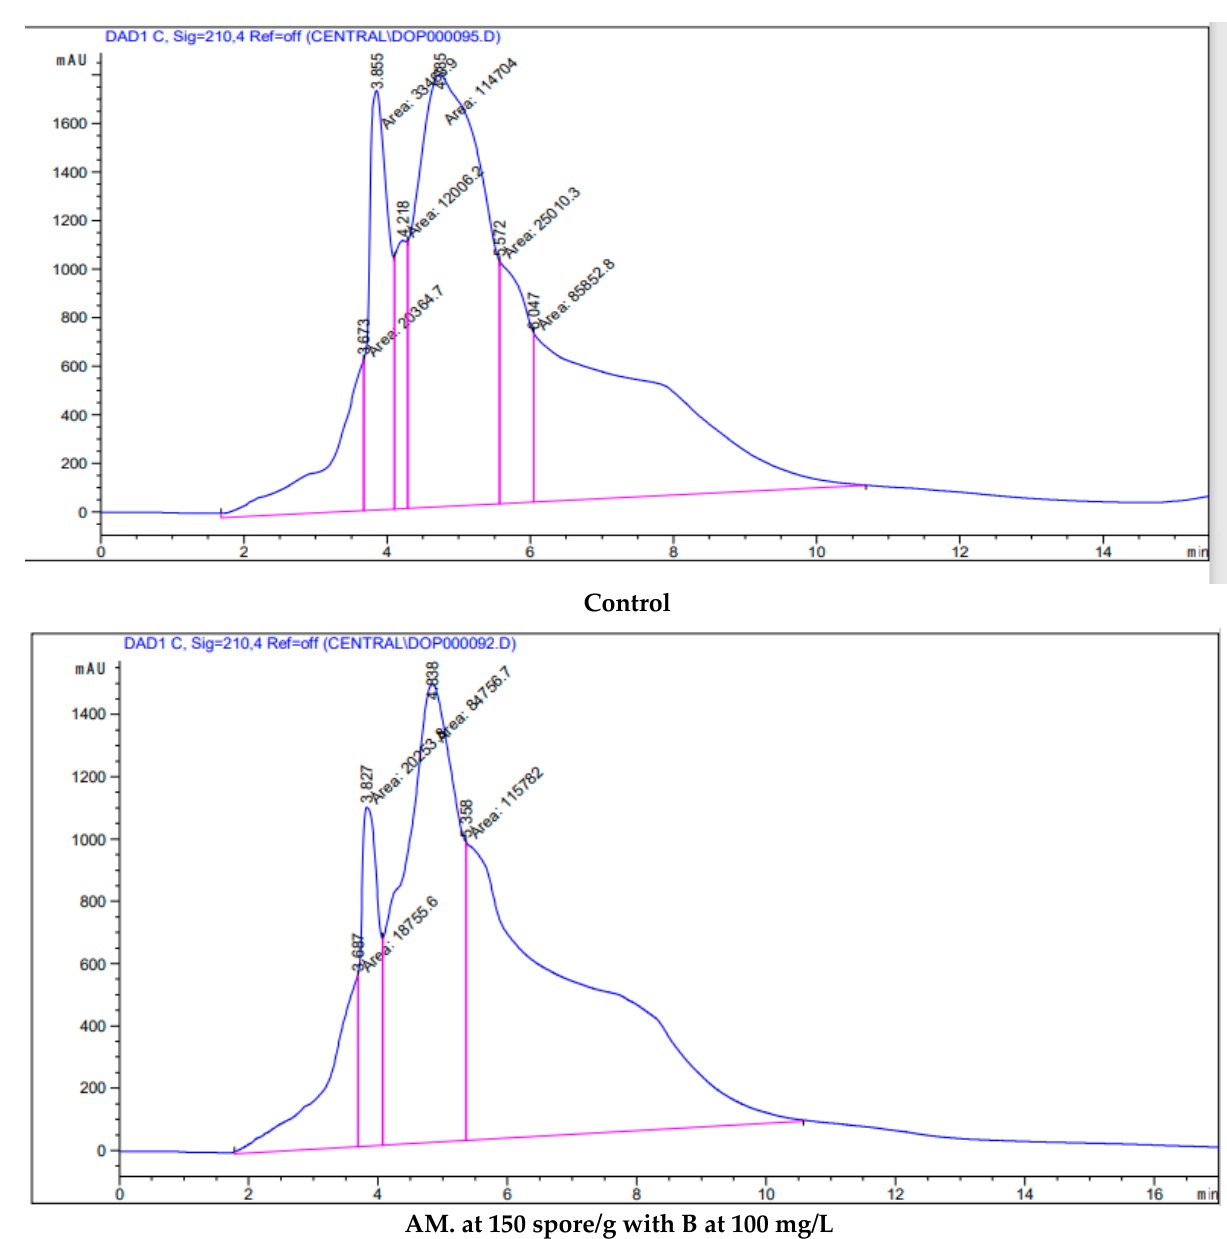
Figure 1. Effect of Arbuscular Mycorrhiza (AM) and Nano B, Zn, and Mo nano microelements on stevioside contents of stevia leaves during 2020 season.